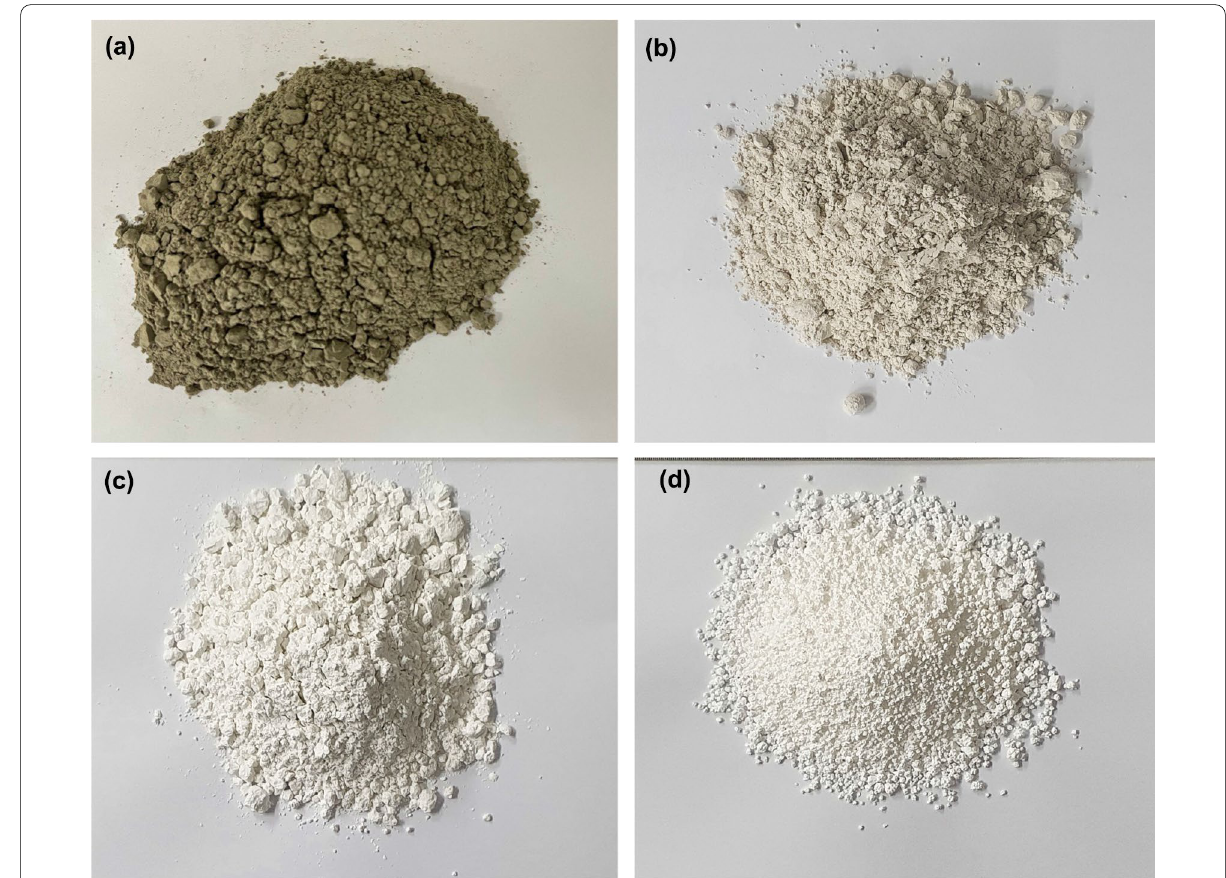
Fig. 1 a OPC; b GGBFS; c CaO and d CaCl 2.